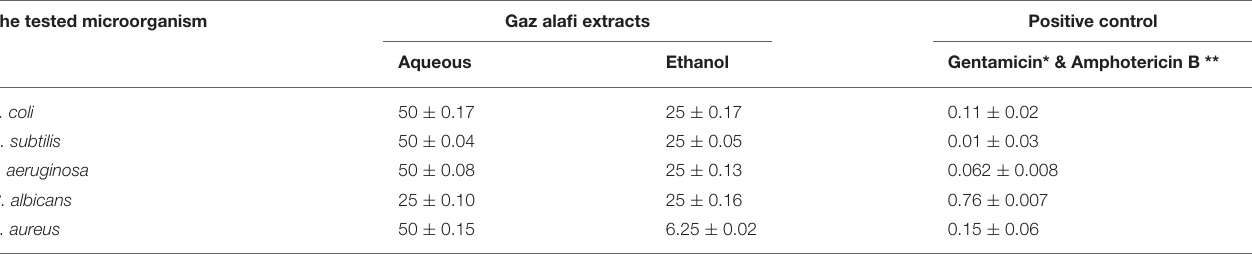
TABLE 6 | Minimum inhibitory concentration (MIC) in mg/ml of Gaz alafi extracts. The tested